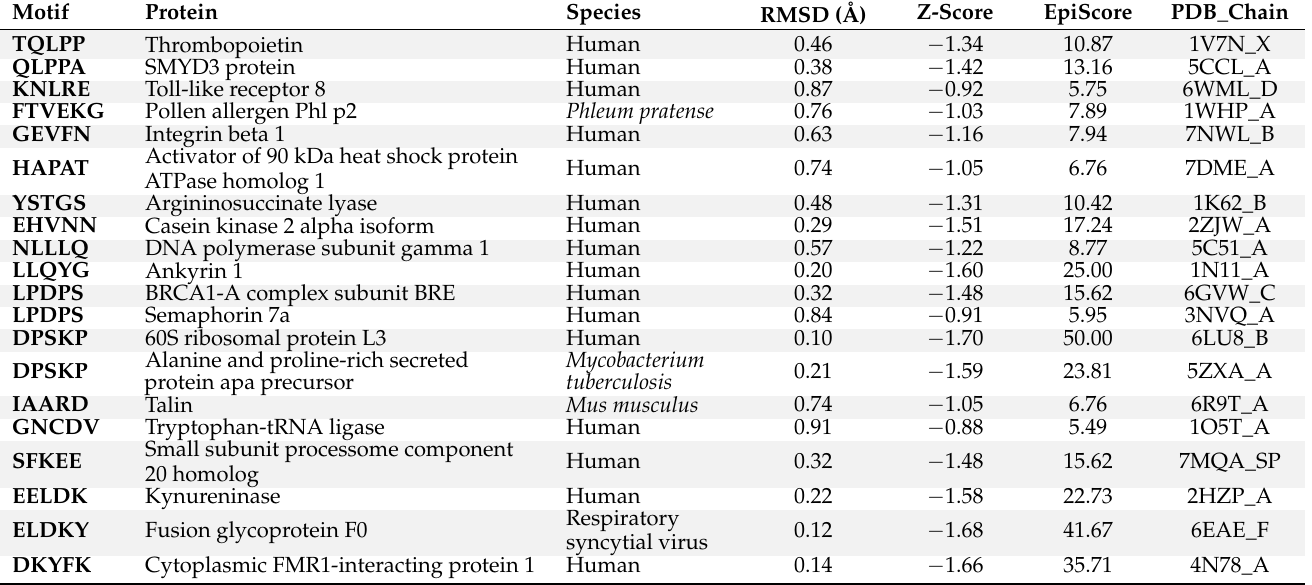
Table 1. 3D-mimics found for SARS-CoV-2 Spike.